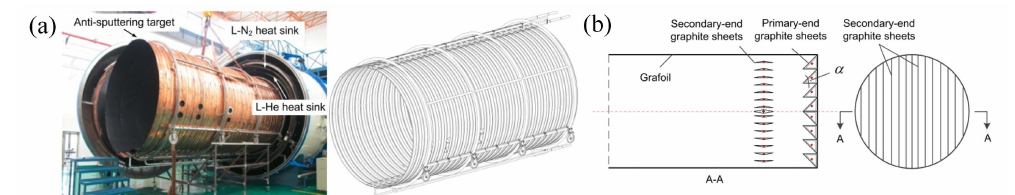
Figure 10. ( a ) Snapshot (left) and schematic (right) of the double-layer anti-sputtering target. ( b ) Schematic of primary-end and secondary-end structures. A–A refers to the cross-section view